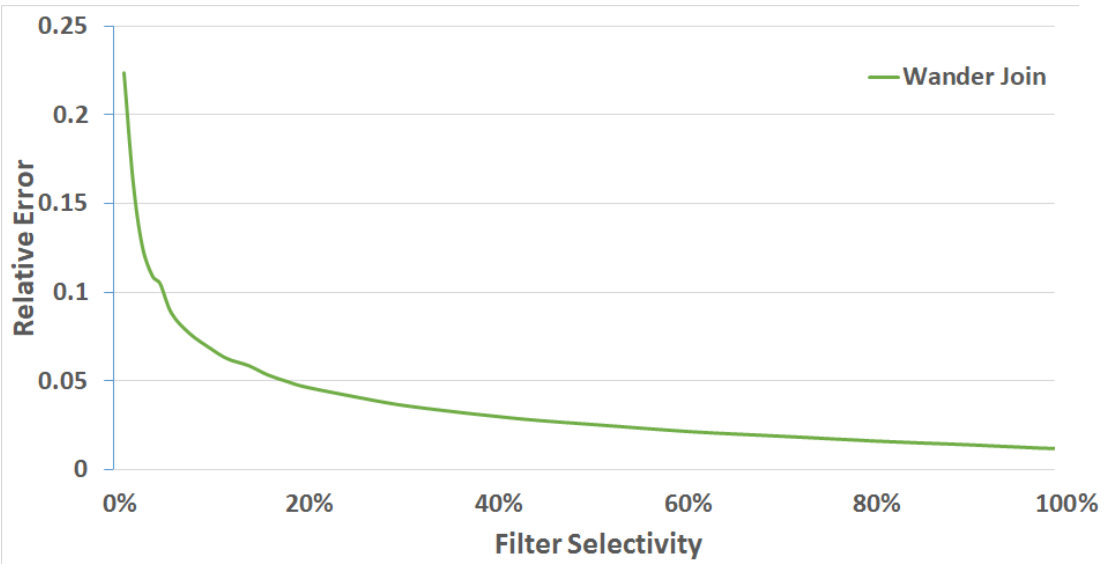
Figure 4. The relative error at 95% confidence level of Wander Join after 10,000 samples over varying levels of selectivity for the TPC-H dataset with scale factor of 0.01 and 60,175 rows in the full JOIN . The selectivity is the percent of records in the full JOIN that pass the filter conditions.The lower the selectivity percentage is, the slower the rate of